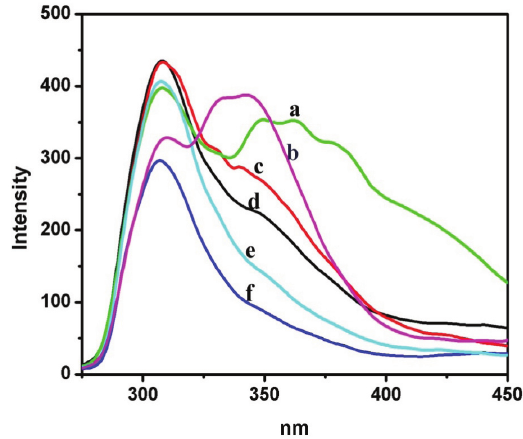
Figure 4: Fluorescence spectra of L and its complexes. (a) Fe(II) complex; (b) Ir(III) complex; (c) Co(II) complex; (d) Ligand; (e) Cd(II) complex; (f) Zn(II)